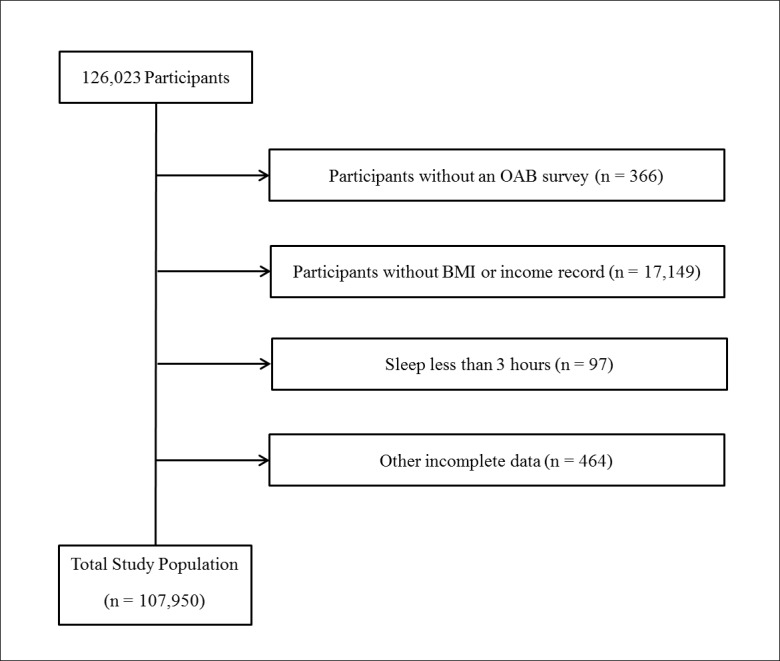
A schematic illustration of participant selection in the present study.Among a total of 126,023 participants, participants without a history of OAB (n = 366), without a BMI or income record (17,149), and with other incomplete data (558) were excluded. The data for the 107,950 participants from whom complete data were obtained were analyzed.